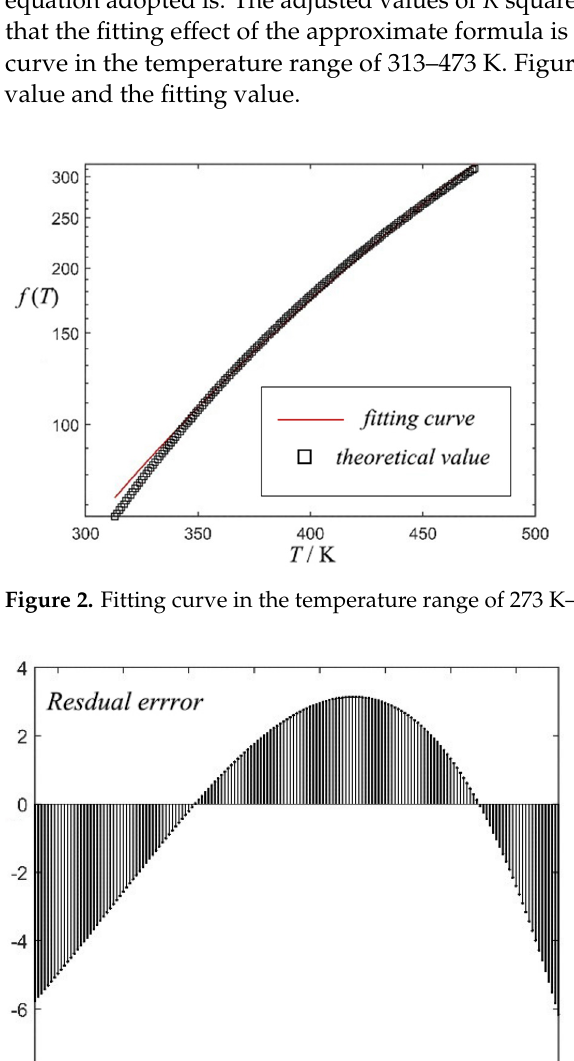
Table 1. n values in the temperature range of testo 882 infrared thermal imager test.